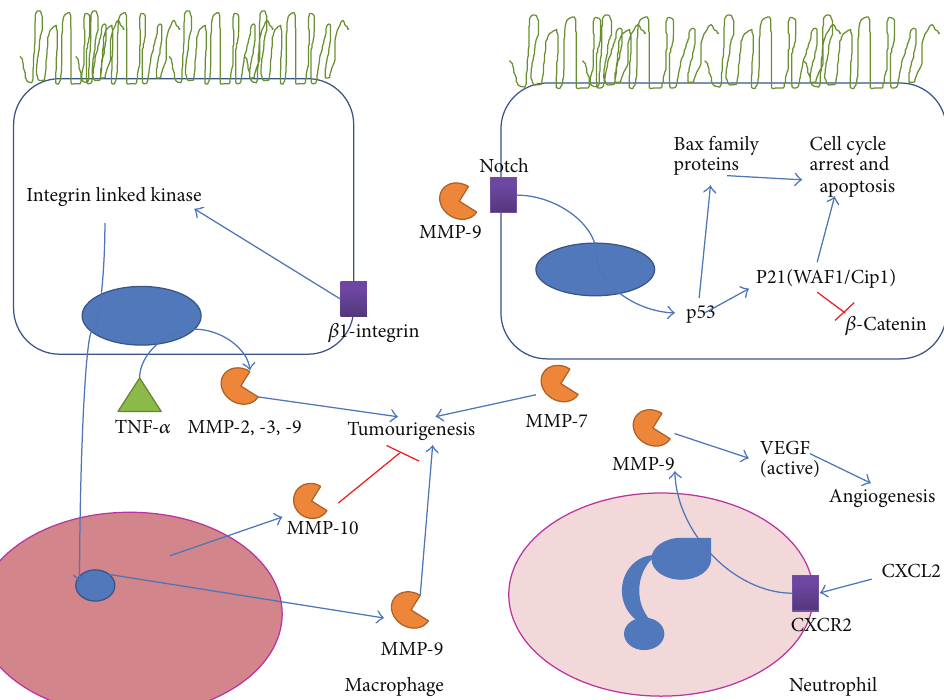
Figure 3: MMPs in colitis associated cancer. A summary of the reported involvement of MMPs in colitis associated cancer (CAC) including the dual roles of MMP-9 where it increases apoptosis and cell cycle arrest through notch cleavage and activation of p53 but also promotes tumour growth, partially through activation of vascular endothelial growth factor (VEGF). MMP-7 is upregulated in UC associated dysplasia and MMP-2 and -3 have also been reported to increase tumour growth. MMP-10 from macrophages is believed to inhibit colitis associated cancer based on a knock-out mouse